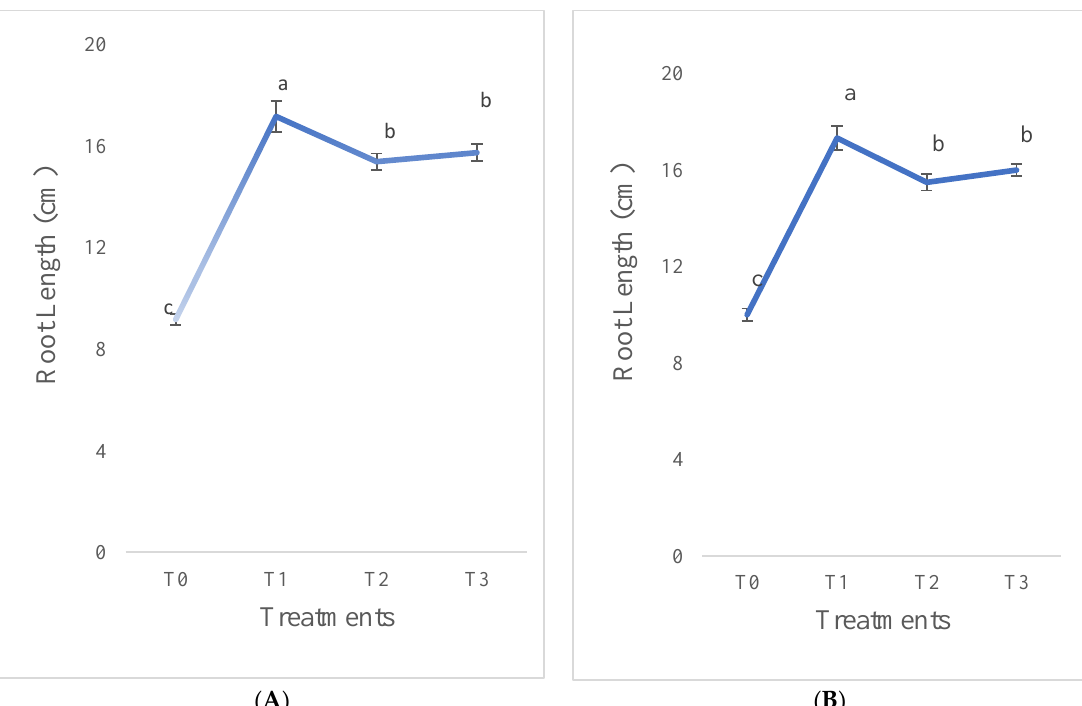
Figure 2. Plant height of lucerne under inoculation with liquid formulation (T0, T1, T2, and T3) of Sinorhizobium meliloti in climatic zone ( A ) = Bronkhorspruit/Gauteng and ( B ) = Hartbeesfoein/Northwest Province). Bars sharing a letter are not significantly different (Lsd Zone A) = 20.148 and (Lsd Zone B) = 20.094. Data are means ± standard errors.